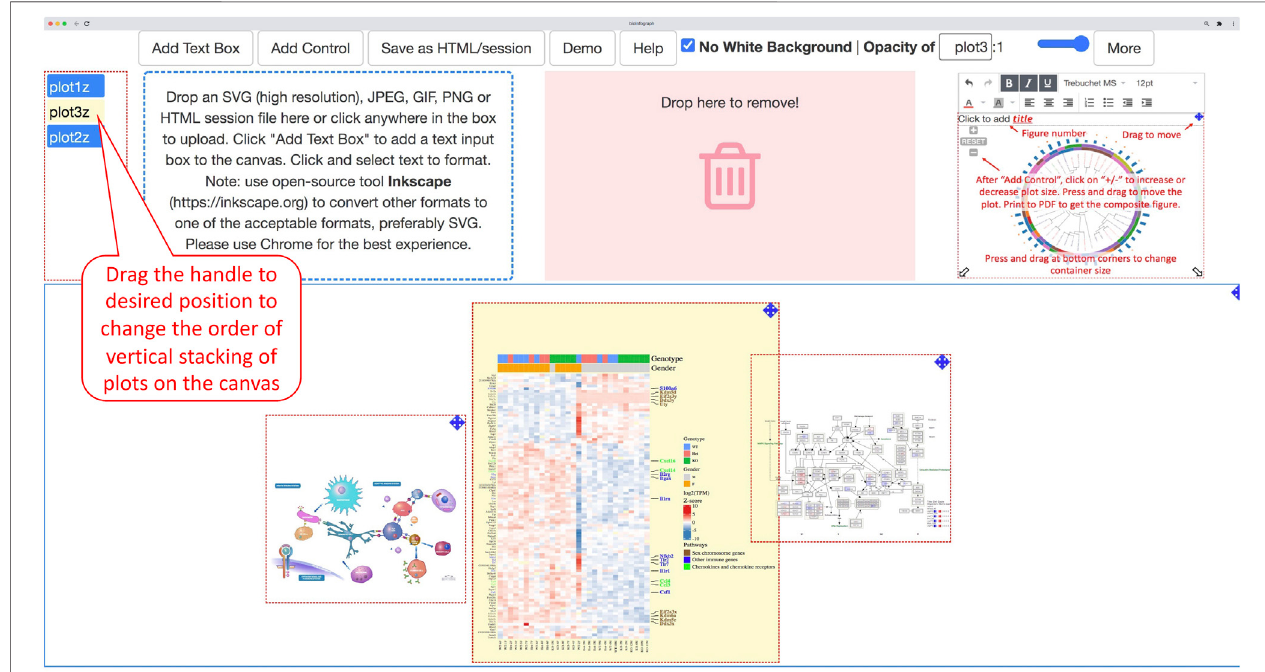
FIGURE5 | Each plotwill get a button handle when itis loaded onto thecanvas. Aplot and the linked handle will be highlighted in yellow when hovering themouse over a handle. Dragging the handle and dropping it at the desired position among these buttons will change the relative vertical stacking, also known as z-index of the plot. The bottom position represents the top layer of the stack of plots on the canvas.